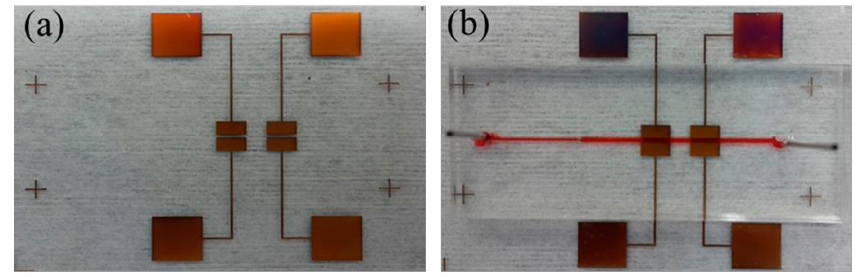
Figure 3. Fabricated device before ( a ) and after having been sealed by PDMS ( b ).